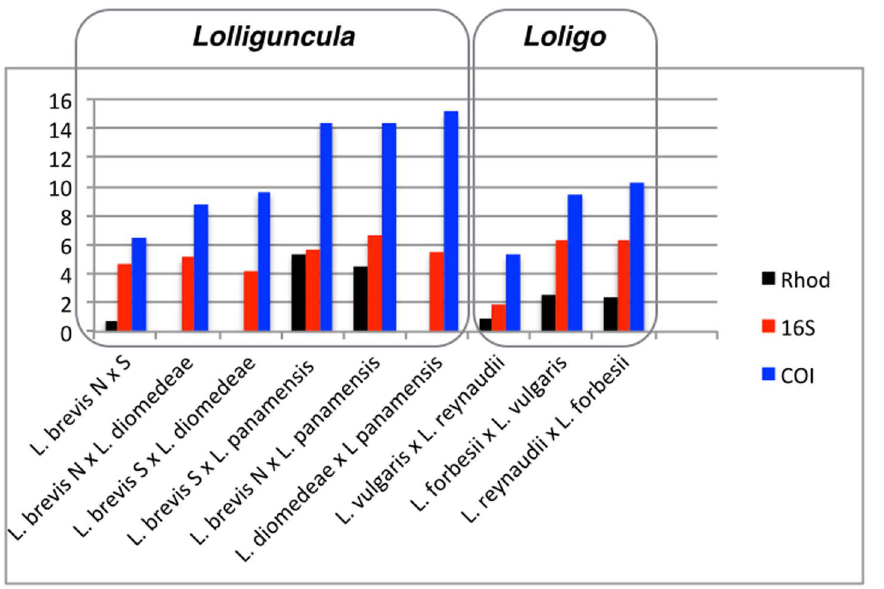
Figure 3. Multilocus species tree of the genus Lolliguncula based in two mitochondrial (16S and COI) and one nuclear genes (Rhod) obtained in the *BEAST program. Posterior probability values are shown at the nodes.